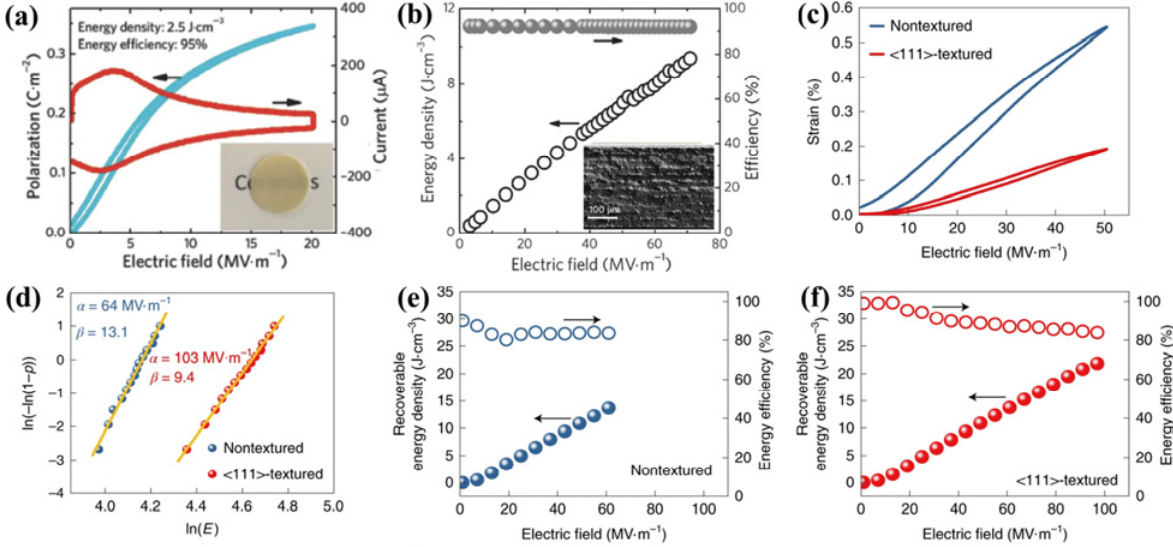
Fig. 24 P – E loops of (a) 0.55NBT–0.45SBT bulk ceramics and (b) 0.55NBT–0.45SBT MLCCs. (c) Strain vs. electric field curves and (d) E b of <111>-textured and nontextured MLCCs. Energy storage performance of (e) nontextured and (f) <111>-textured multilayer ceramics. Reproduced with permission from Ref. [5] for (a, b), © WILEY-VCH Verlag GmbH & Co. KGaA, Weinheim 2018; Ref. [57] for (c–f), © The Author(s), under exclusive licence to Springer Nature Limited